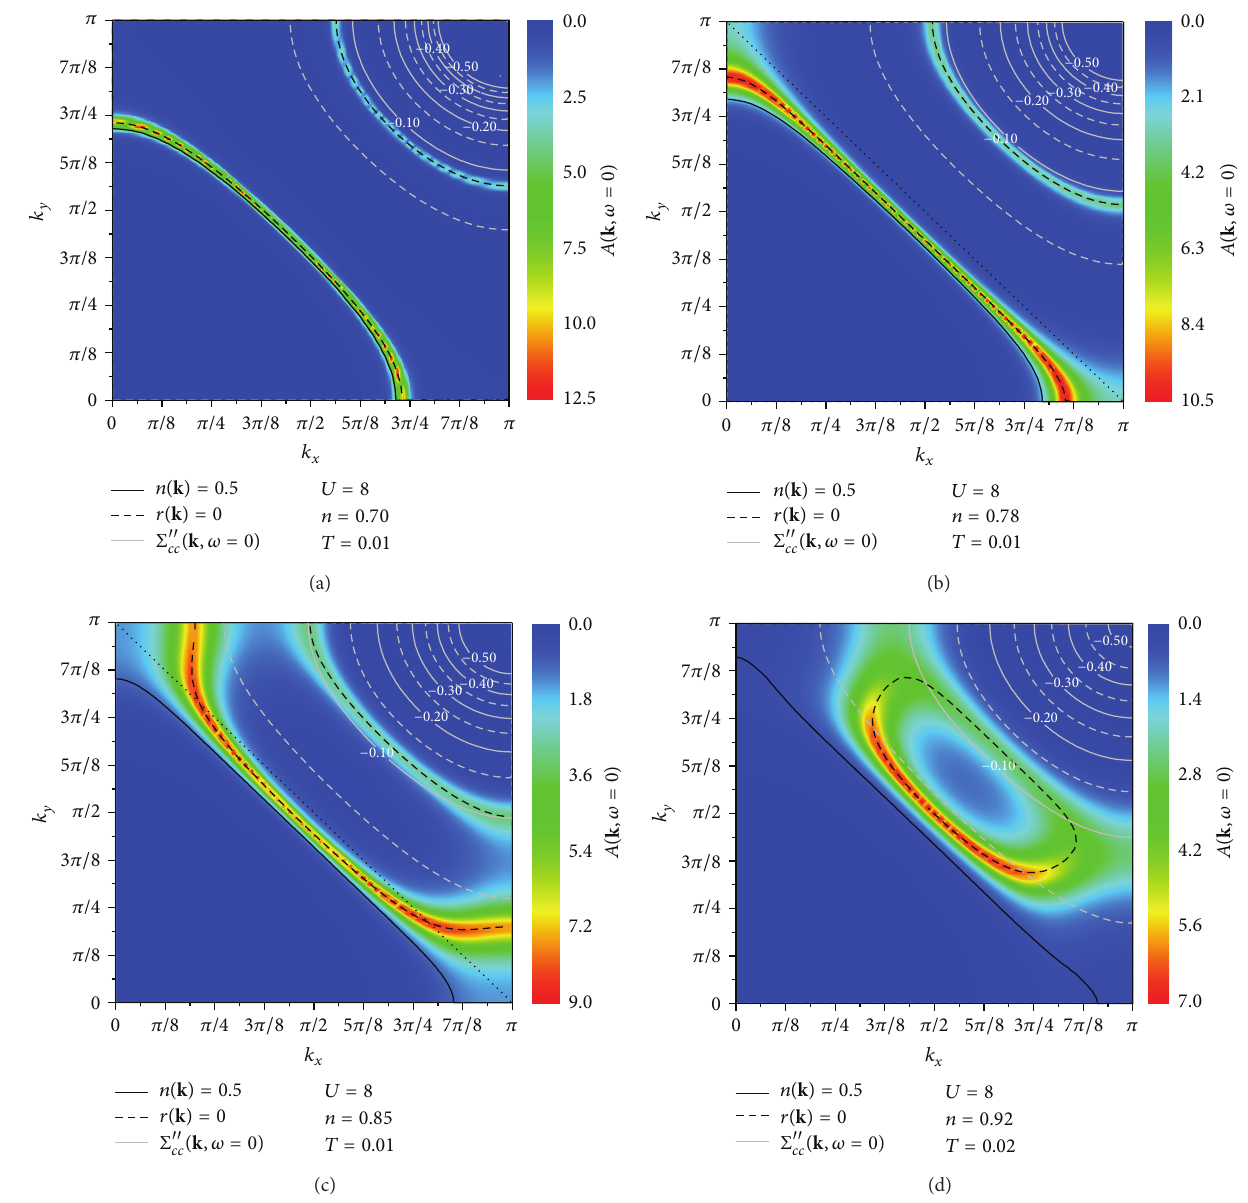
Figure 5: (Color online) Spectral function at the chemical potential 𝐴( k ,𝜔 = 0) as a function of momentum k for 𝑈 = 8 , 𝑇 = 0.01 and (a) 𝑛 = 0.70 , (b) 𝑛 = 0.78 , (c) 𝑛 = 0.85 , and (d) 𝑛 = 0.92 ( 𝑇 = 0.02 ). The solid line marks the locus 𝑛( k ) = 0.5 , the dashed line marks the locus 𝑟( k ) = 0 , the gray lines are labeled with the values of Σ 󸀠󸀠 𝑐𝑐 ( k ,𝜔 = 0) , and the dotted line is a guide to the eye and marks the reduced (antiferromagnetic) Brillouin